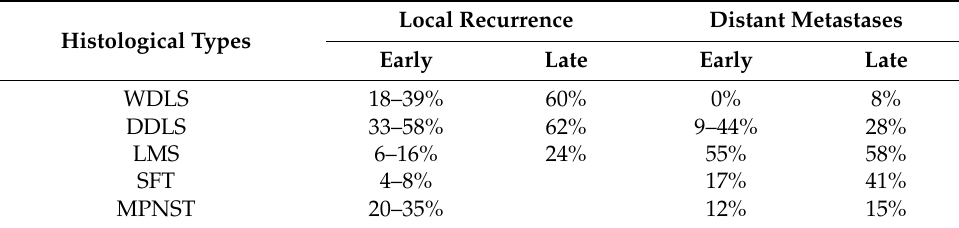
Table 3. Risk of local recurrence and distant metastases of the most common retroperitoneal sarcoma histologic types according to two recent series [29,37]. Early recurrence: ≤ 5 years from the operation; late recurrence: 5–15 years from the operation